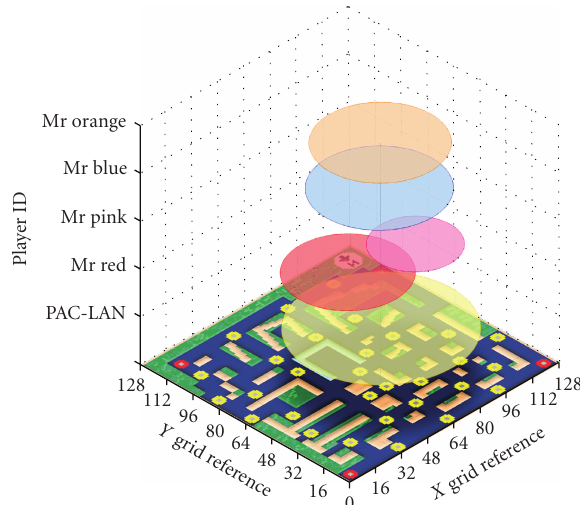
Figure 7: Players’ mean displacement from their averaged